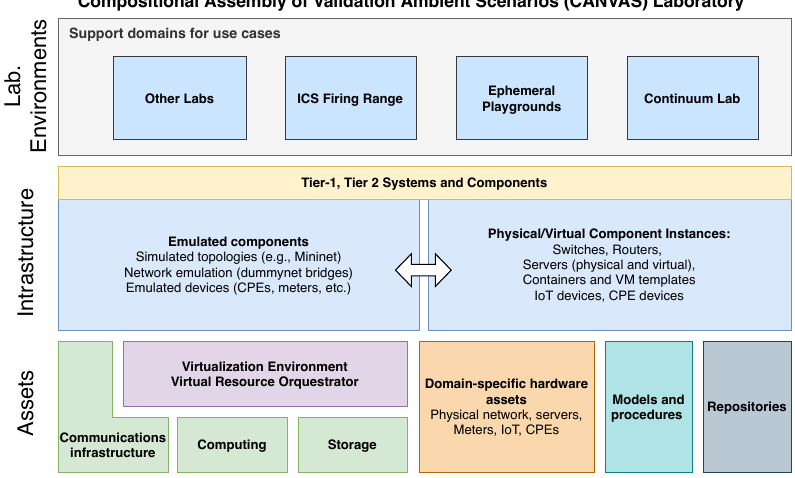
Figure 1. CANVAS laboratory